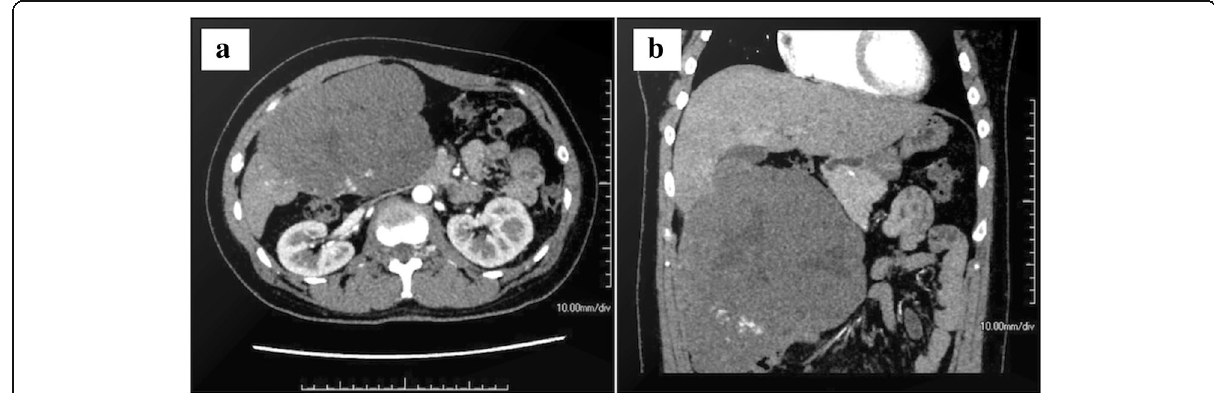
Fig. 1 Contrast-enhanced computerized tomography showing a giant liver hemangioma originating from segments 5/6, with extrahepatic growth. a Axial section. b Coronal